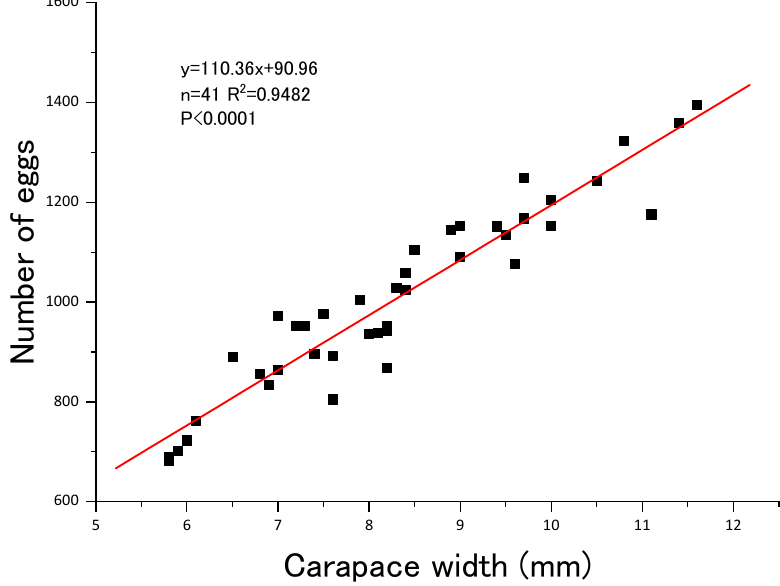
Figure 8. Frequency of young juveniles and ovigerous females by distance from the Kita River mouth during the sampling periods.